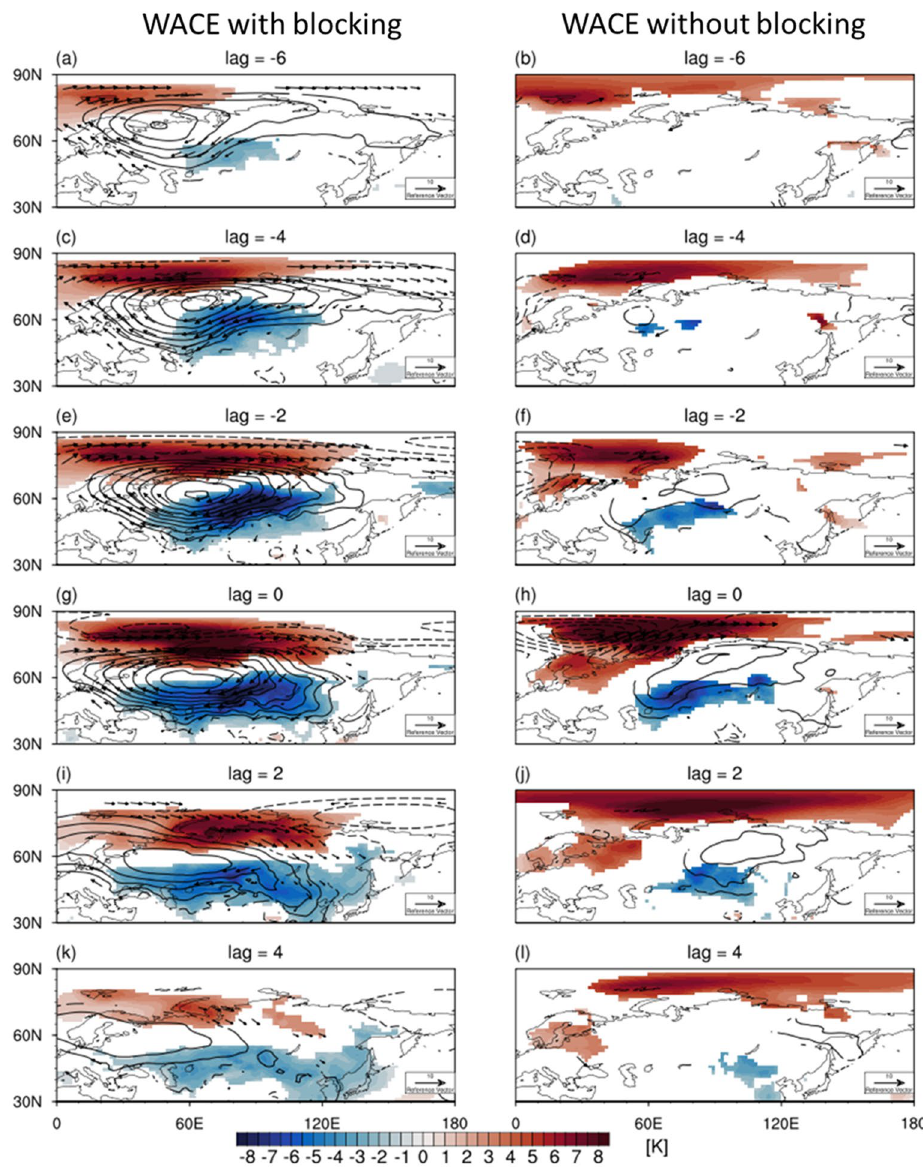
Figure 3. Same as Fig. 2 but for WACE cases (left) with blocking and (right) without blocking. Figures were created with the NCAR Command Language 6.6.2 (http://dx.doi.org/10.5065/D6WD3